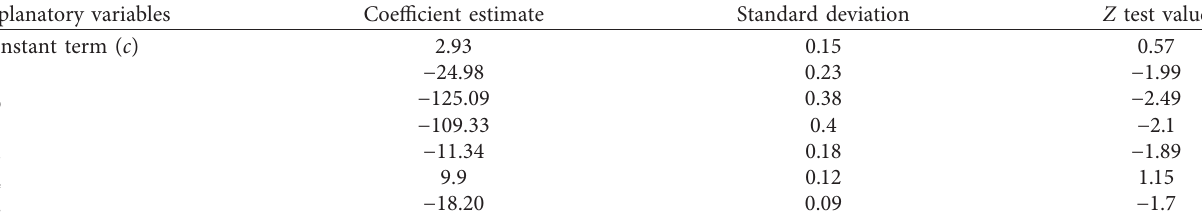
Table 1: Regression results of logit model in the data panel.